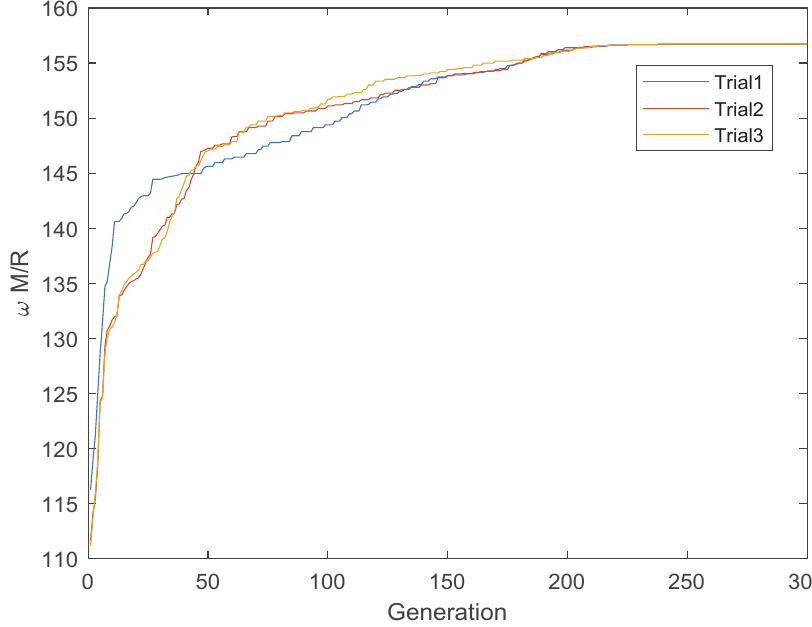
Figure 8. Evolution of the genetic